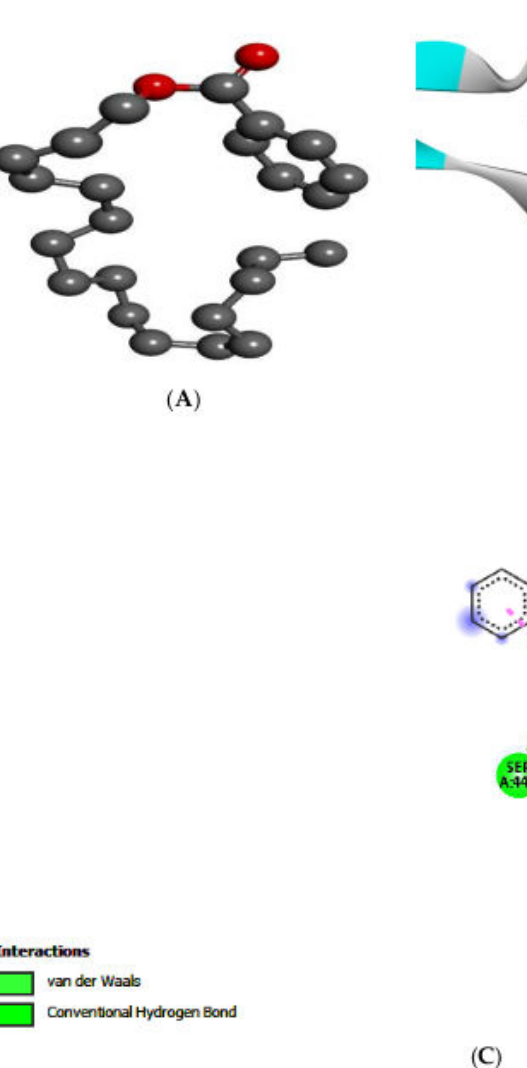
Figure 4. Interactions of legend (compound 2 ) with Leishmania tropica promastigote surface gp63 enzyme, drawn through Discovery Studio Visualizer client 2016. ( A ) PDB structure and best pose of octadecyl benzoate; ( B ) General interaction of octadecyl benzoate with its targets; ( C ) Specific interaction of compound 2 with its